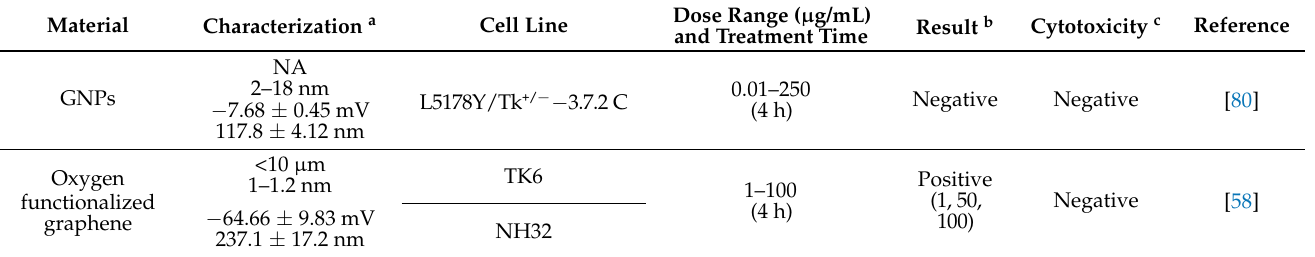
Table 3. In vitro studies assessing the genotoxicity of GBMs using the mammalian gene mutation assay.